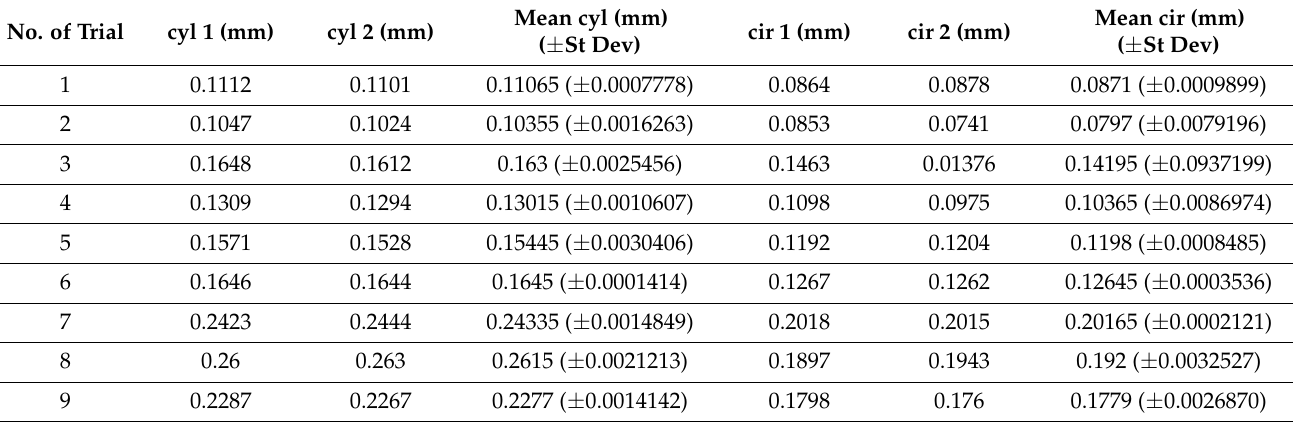
Table 3. Measured values of cylindricity and circularity.